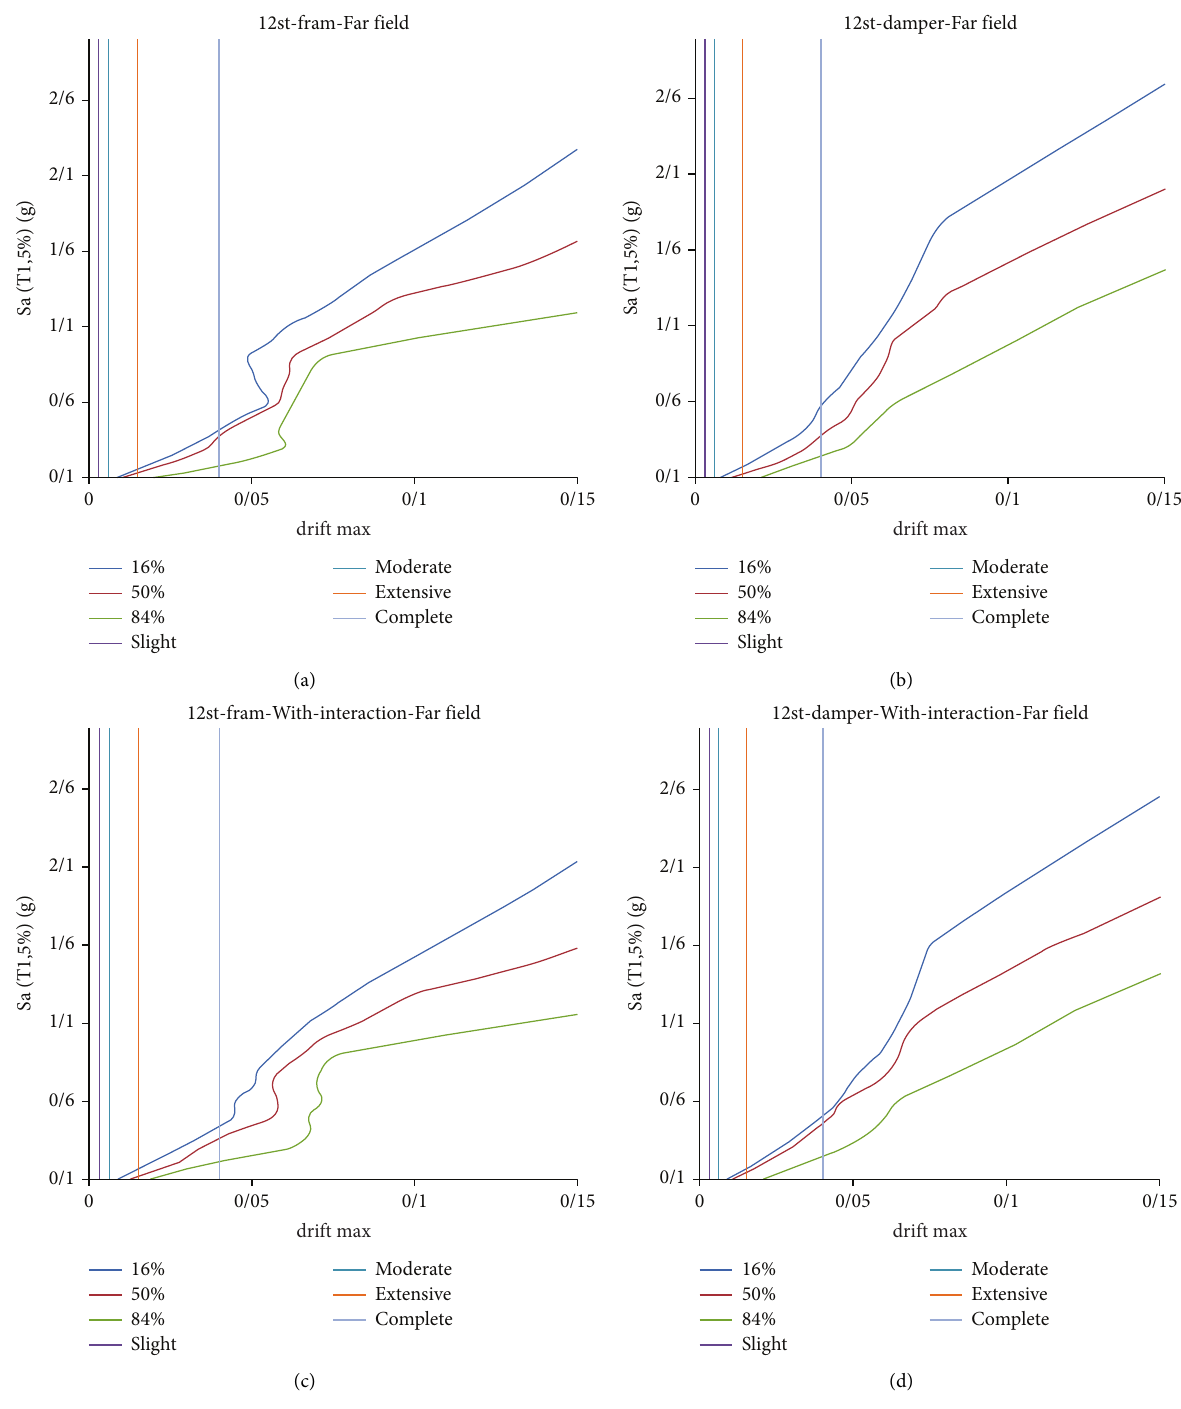
Figure 15: Summary of IDA curves for 16%, 50%, and 84% percentiles in 12-story ordinary moment resisting frame affected by far-field earthquakes. Examined cases: (a) with damper without considering SSI; (b) without damper and SSI effect; (c) with damper and considering SSI; (d) without damper but considering SSI